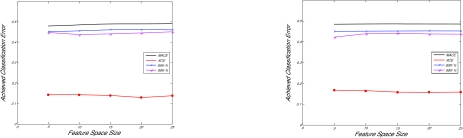
PACE analysis using a SVM-based classifier using the weighted separability scoring criterion, with a 0.6 MAC threshold. Left Panel: performance without peak selection. Right panel: performance with peak selection.